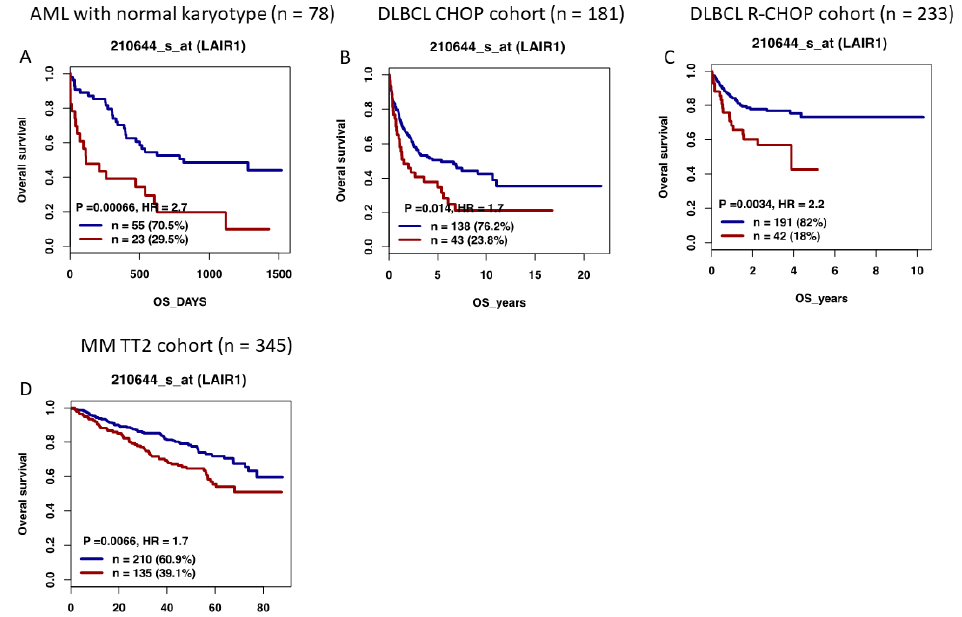
Figure 4. Prognostic value of LAIR1 expression in patients with DLBCL. ( A ) Cytogenetically normal AML patients from the GSE12417 cohort ( n = 78) were ranked according to increased LAIR1 expression (Affymetrix U133P microarrays), and the maximum difference in OS was obtained by splitting patients into high-risk and low-risk groups. ( B , C ) High LAIR1 expression also had prognostic value in DLBCL, including the Lenz CHOP cohort (n = 181) and Lenz R-CHOP cohort ( n = 233) (Affymetrix U133P microarrays). ( D ) LAIR1 expression was also significantly associated with a poor outcome in MM (n = 345, Affymetrix U133P microarrays). Blue: low expression of LAIR1; red: high expression of